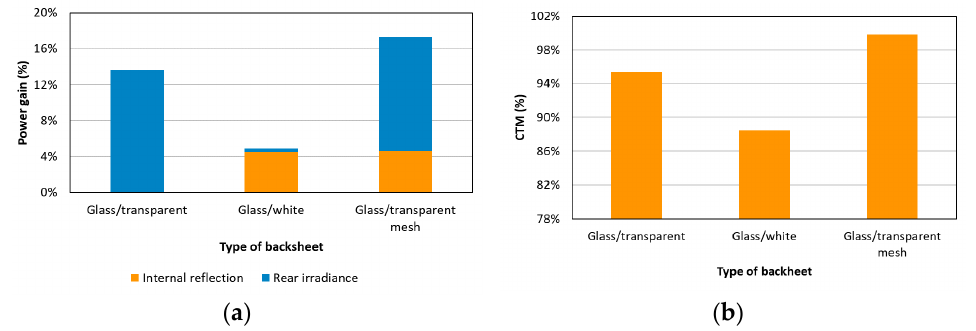
Figure 16. Performance of bifacial PV module with transparent mesh backsheet depending on type of backsheet: ( a ) power gain depending on internal reflection and rear irradiance at each type of depending on internal reflection and rear irradiance at each type of backsheet; ( b ) CTM ratio depending on type of backsheet; ( b ) CTM ratio depending on type of backsheet.